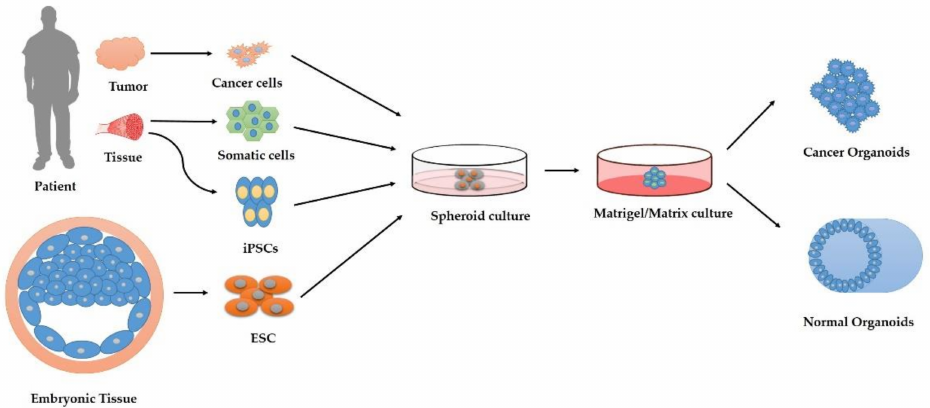
Figure 4. The development of organoids from primary cells, stem cells, and cancer cells. Embryonic stem cells (ESC) from embryonic tissue and iPSCs derived from adult primary tissue first experience direct differentiation into a floating spheroid culture. The culture is subsequently transferred into a matrix-based hydrogel with a specific medium to initiate the formation of organoids. Somatic stem cells can be obtained from patient tissue, which can be further cultured in a 3D medium to develop it into organoids. Cancer cells from tumor tissue can be developed into tumoroids in a specific 3D